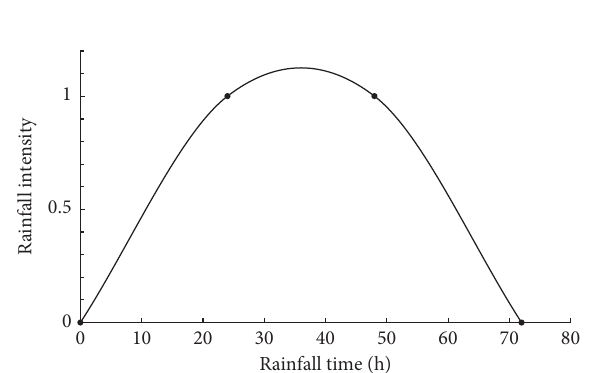
Figure 7: Curve of rainfall intensity amplitude.